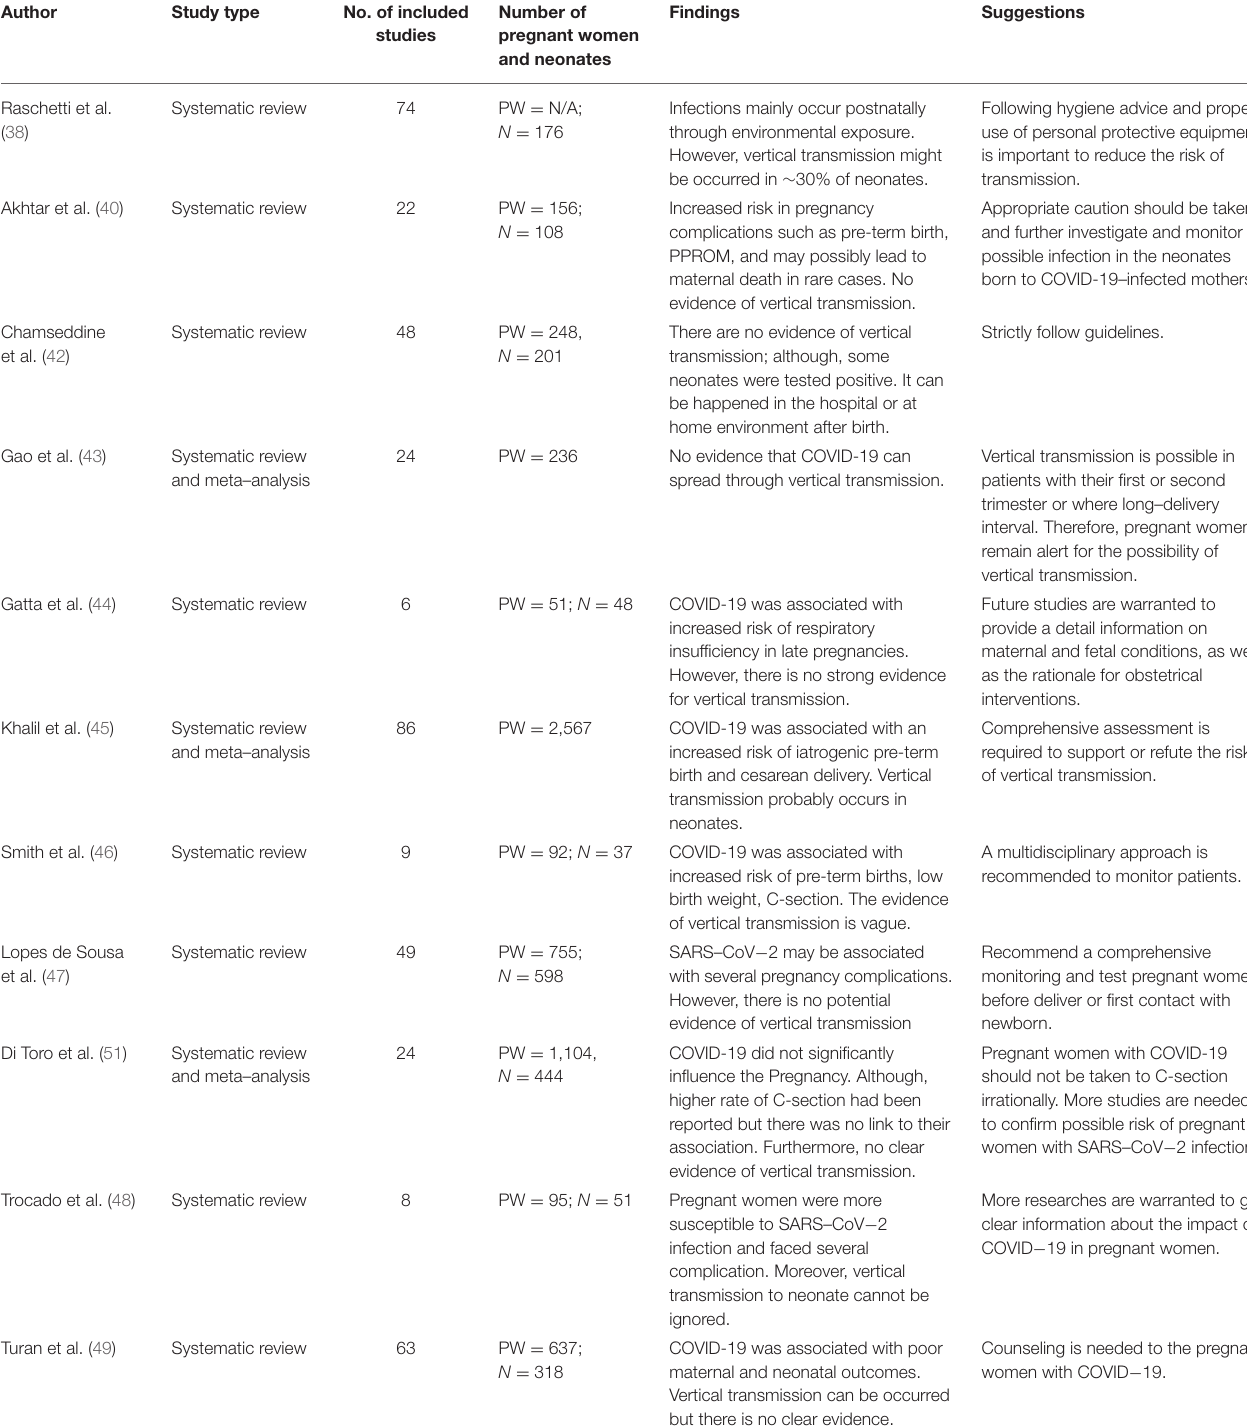
TABLE 4 | Basic characteristics, findings and suggestions from recent